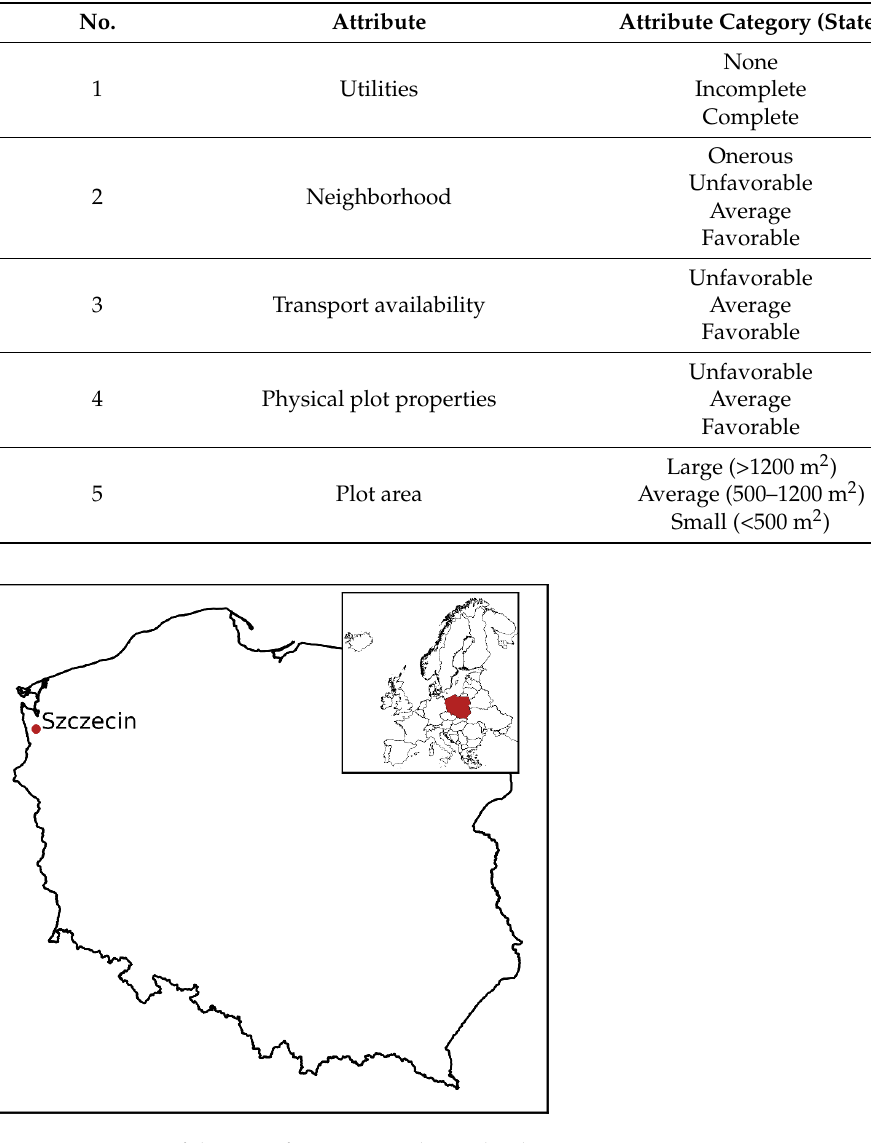
Figure 2. Designated location of the attractiveness zones.